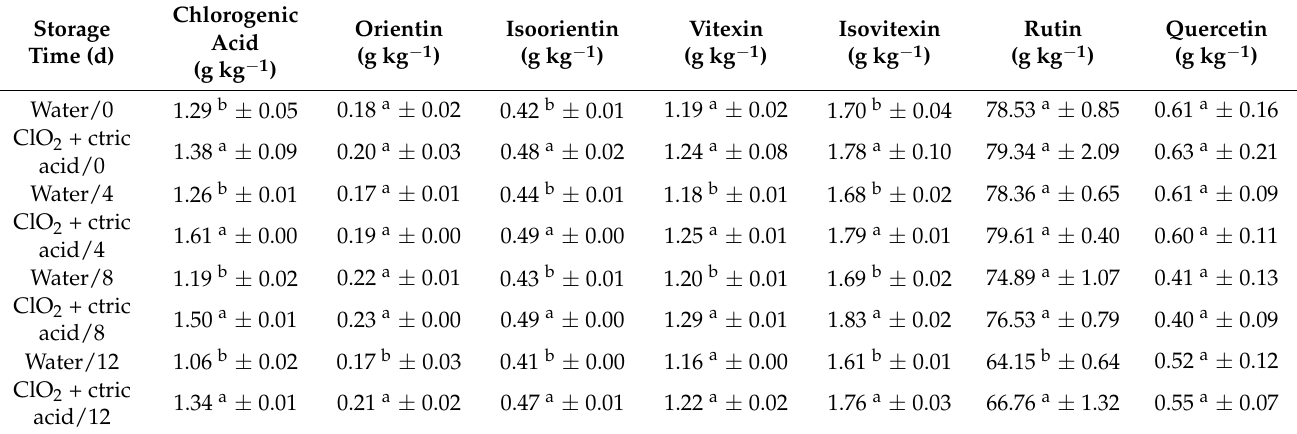
(Table 1). Similar to the changes of total flavonoids in microgreens during storage, the content of these compounds was maintained in the initial 4 d storage and then decreased till the end of storage in both groups. Moreover, ClO 2 + citric acid -washed microgreens also exhibited higher contents of all these compounds during the whole storage. Table 1. Changes in the contents of major phenolic